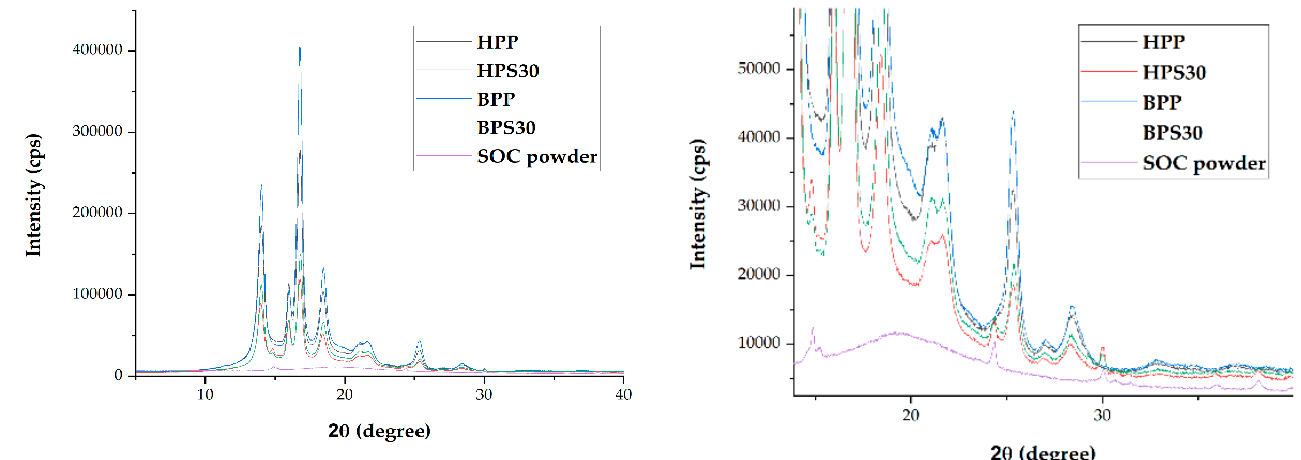
Figure 3. X ray diffraction (XRD) result of SOC powder and PP/SOC specimens. Table 5. Relative crystallinity of SOC powder and PP/SOC